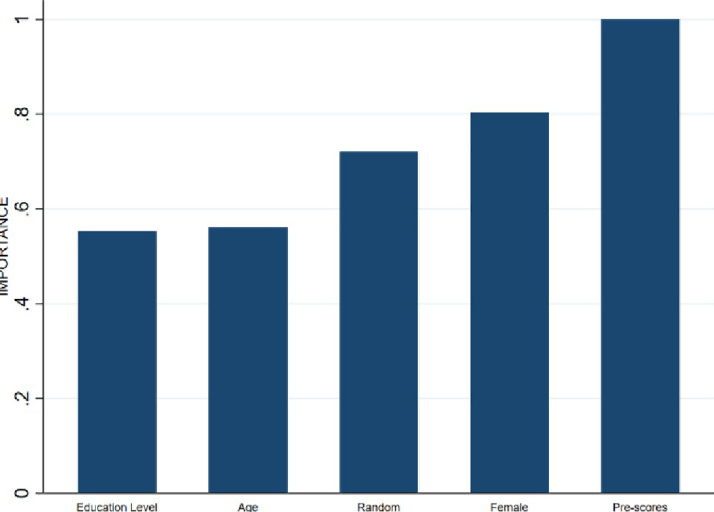
Fig 4. Importance graph simulated attrition. The relative importance of the intervention variable is excluded from the figure, as only background characteristics are to be considered for tightening Random Forest Lee Bounds.